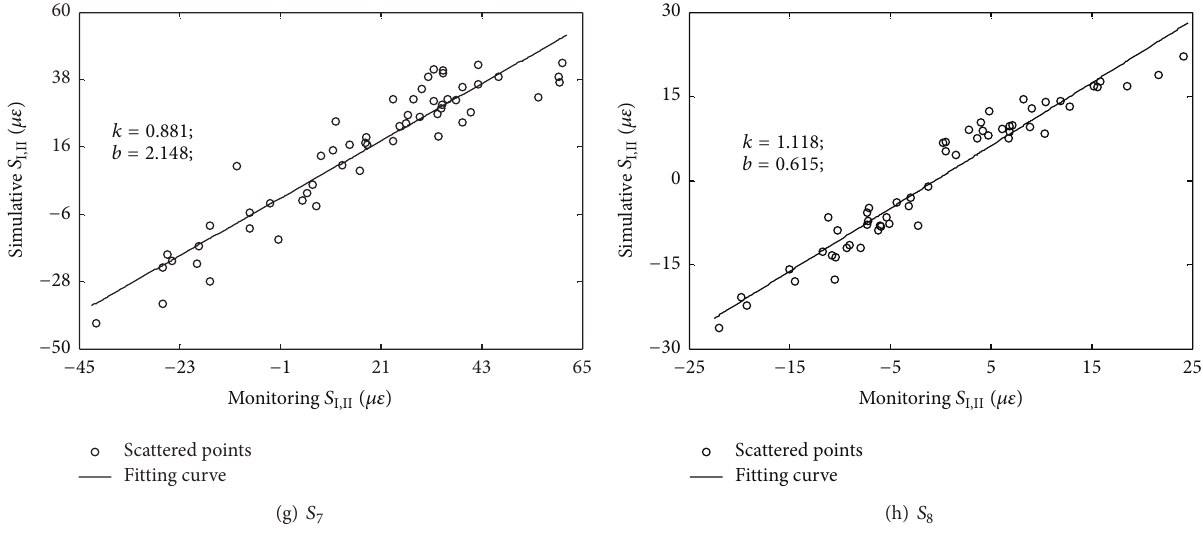
Figure 16: Correlation between simulative 𝑆 I , II and monitoring 𝑆 I , II .